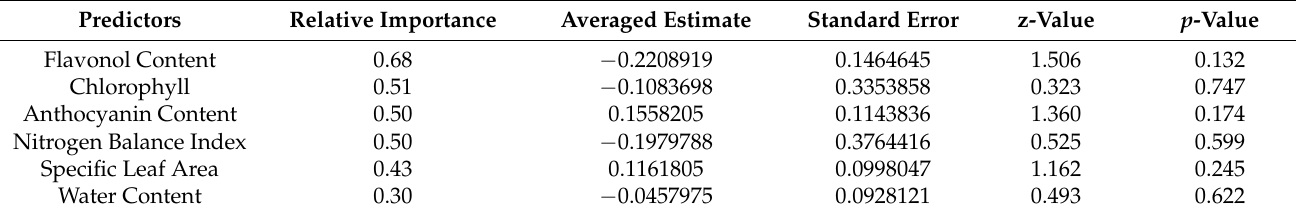
Table 2. Summary of the GLMM Model Averaging ( n = 64 models) to test the overall relative importance of each ecophysio- logical parameter in explaining gall presence across all species. A negative average estimate indicates that galled leaves had lower levels of the measured variable than ungalled leaves. z-value and p -value come from averaged